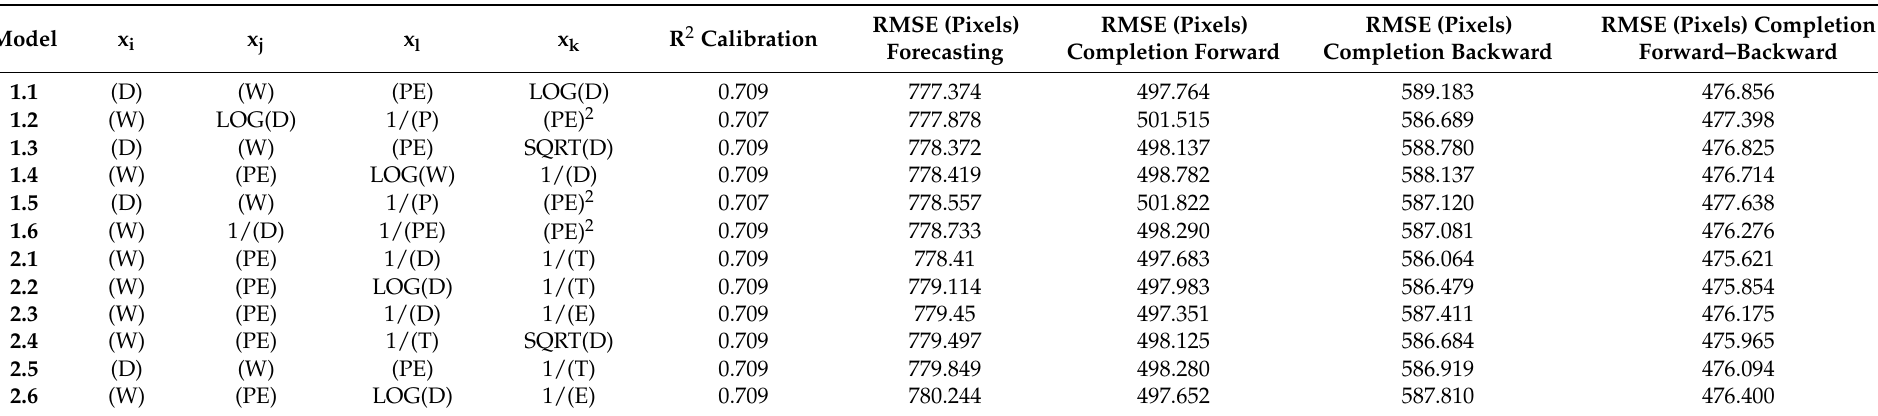
Table 1. Regression models used to obtain the ensemble and its performance in terms of R 2 in the calibration and RMSE in the re-analysis. P is precipitation, PE is effective precipitation, T is temperature, E is potential evapotranspiration, D is aquifer discharge, and W is the surface water in the previous